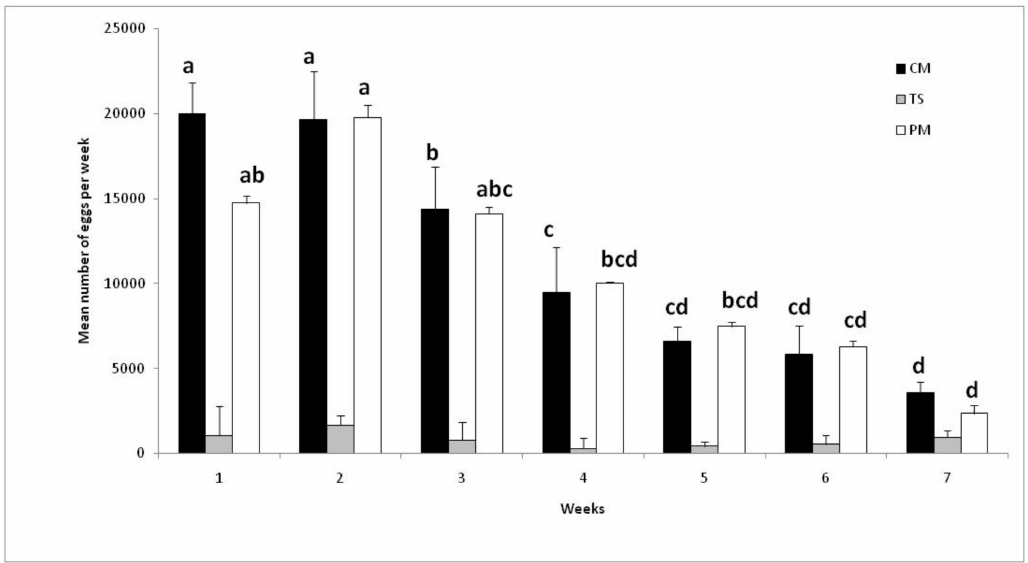
Figure 2. Number of eggs produced by cages fed with cellulose membrane (CM), turkey skin (TS), and Parafilm ® membrane (PM). Histograms with the same letter indicate that the results are not significantly di ff erent ( p > 0.05, Tukey’s HSD post hoc test following an ANOVA procedure within each treatment). No letters indicate no significant di ff erence between the